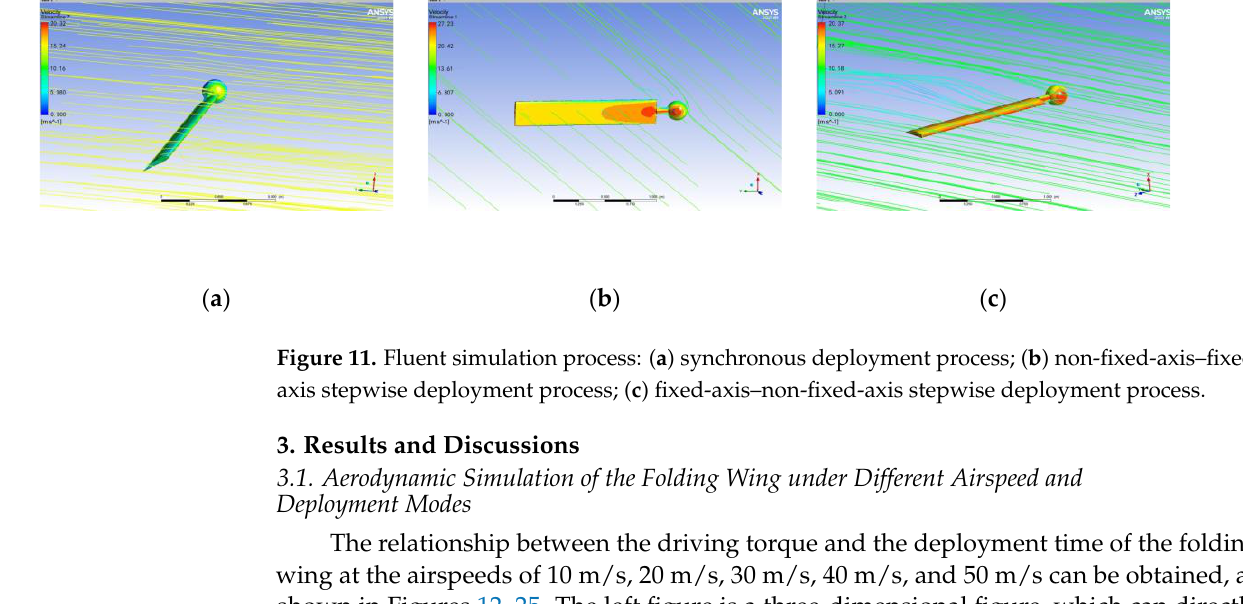
Figure 10. Mesh generation.